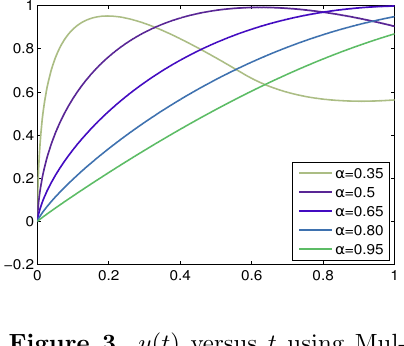
Figure 3. y ( t ) versus t using Mul- tiquadric basis function with ε = 10 − 4 for p ( t ) = 1 and q ( t ) = for different value of α